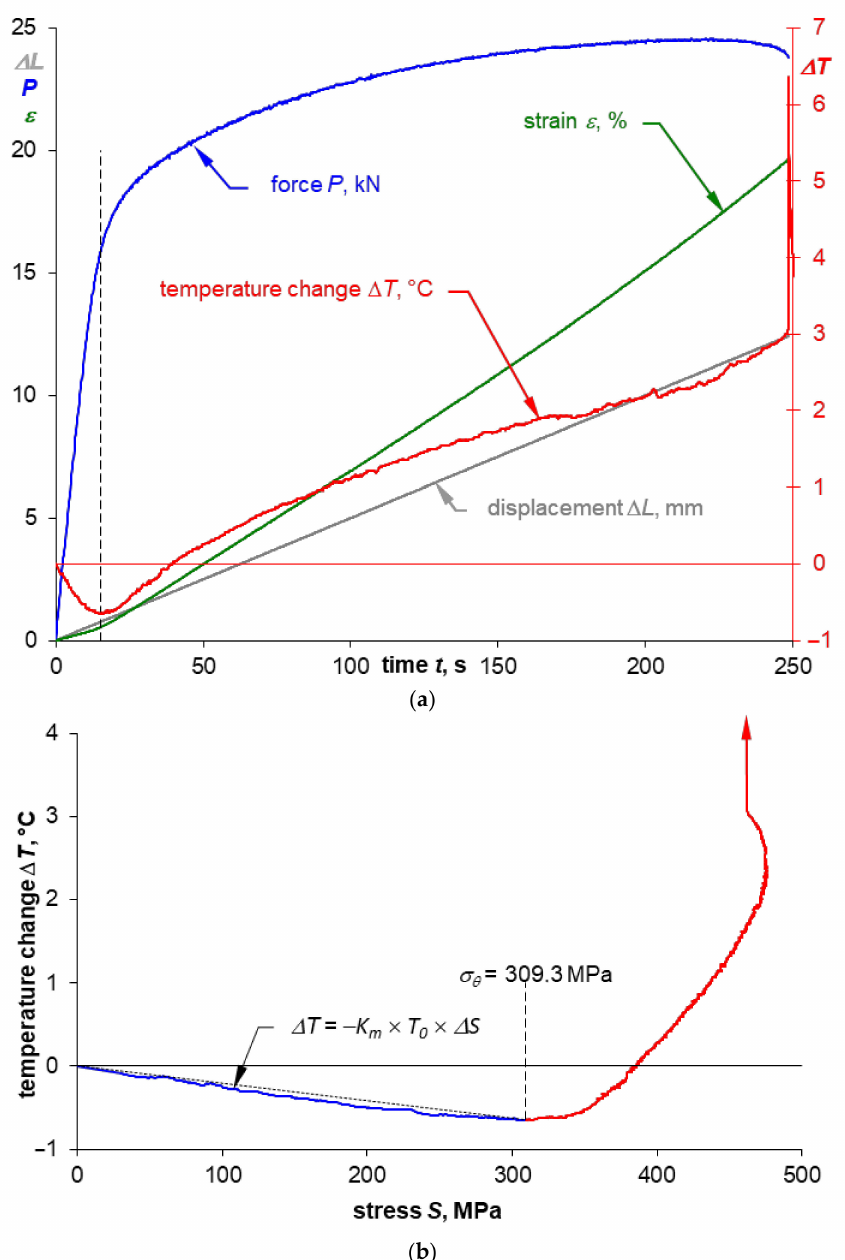
Figure 8. Sample time courses of the parameters recorded during the monotonic tensile test ( a ) for a specimen made of 0.16” thick 2024-T3 sheet plate cut perpendicular to the rolling direction and the temperature-strain relation ( b ) including the marking of the thermoelasto-plastic limit stress σ θ